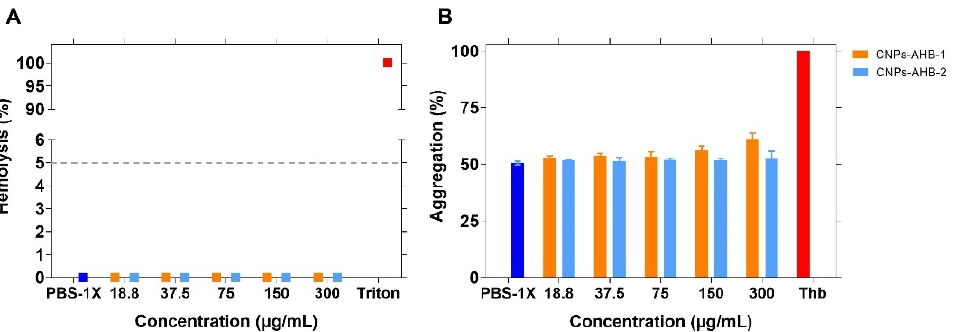
Figure 9. In vitro biocompatibility assays for CNPs-AHB-1 (in orange) and CNPs-AHB-2 (in light blue) nanobioconjugates. ( A ) Nanobioconjugates exhibited a low hemolytic activity comparable to the PBS-1X used as a negative control. The positive control was Triton X-100. ( B ) Nanobioconjugates showed low platelet aggregation compared with PBS-1X as negative control and Thrombin as a positive control.